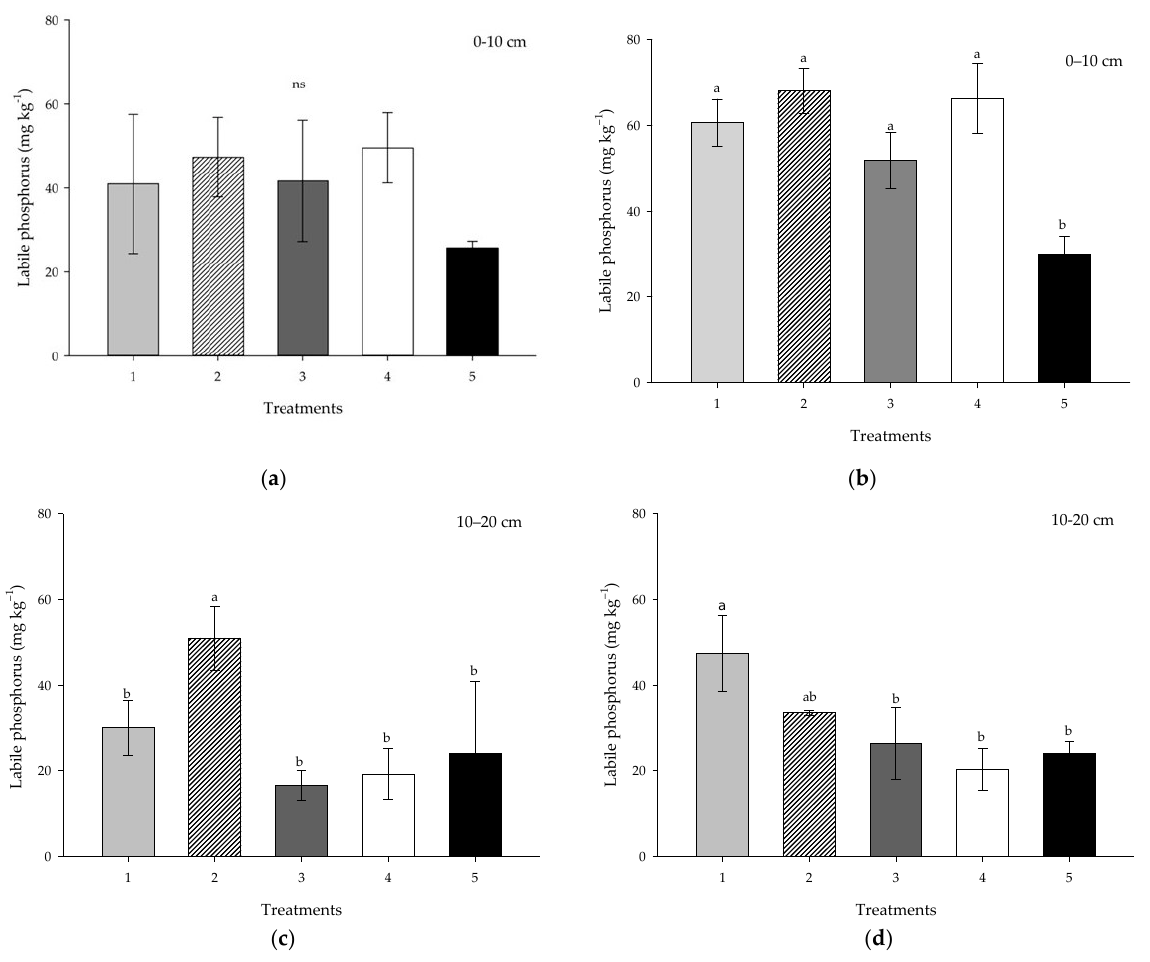
Figure 3. Labile phosphorus in the soil after three ( a , c ) and six years ( b , d ) of the experiment establishment, at 0–10 and 10–20 cm layers. Treatment 1: full correction + maintenance at seed furrow; Treatment 2: full correction incorporated + maintenance at seed furrow; Treatment 3: full correction at seed furrow + maintenance on broadcast; Treatment 4: full correction + maintenance both broadcasted; Treatment 5: gradual correction + maintenance at seed furrow. Means followed by different letters differ by Tukey test at 5% probability; ns: not significant. Error bars (±) indicate the standard deviations of 3 replicates.